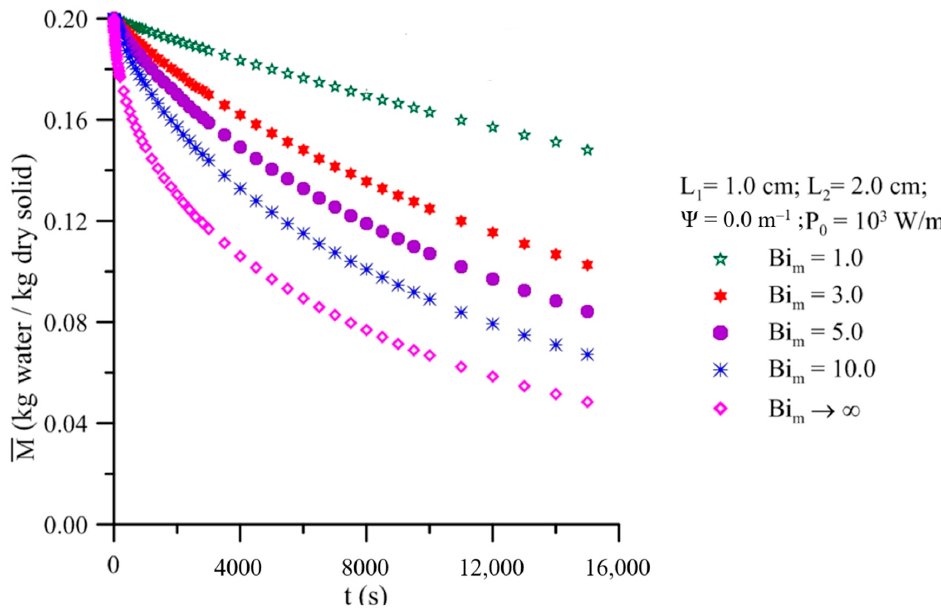
Figure 6. Transient behavior of the average moisture content in a prolate spheroidal solid with aspect ratio 2.0, different mass transfer Biot numbers and fixed microwave power density.